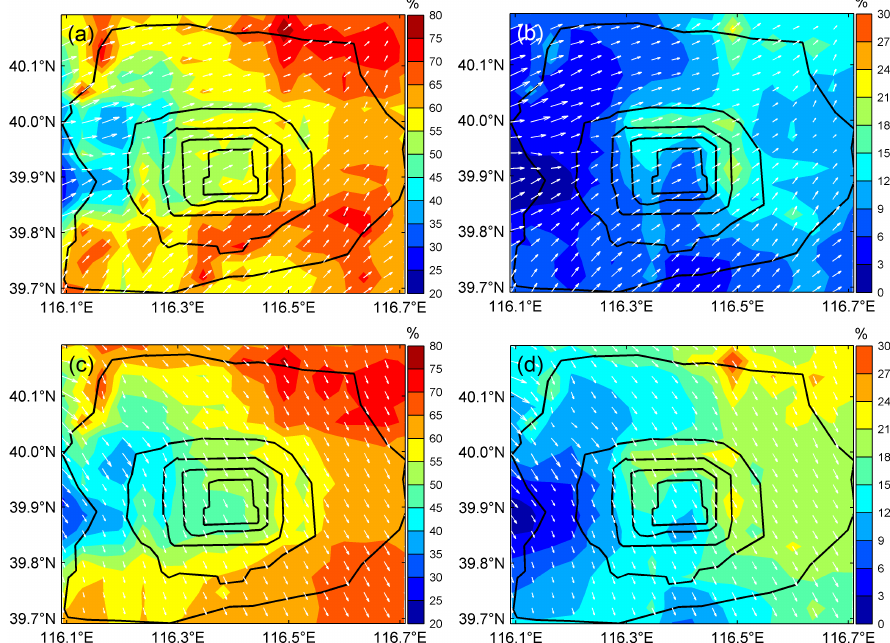
Figure 10. The spatial distribution of vehicle emission contribution in local emission to NO 2 and PM 2 . 5 in July (a, b) and December (c, d) 2013. Black lines represent the main traffic arteries in Beijing; white arrows represent near-surface mean wind